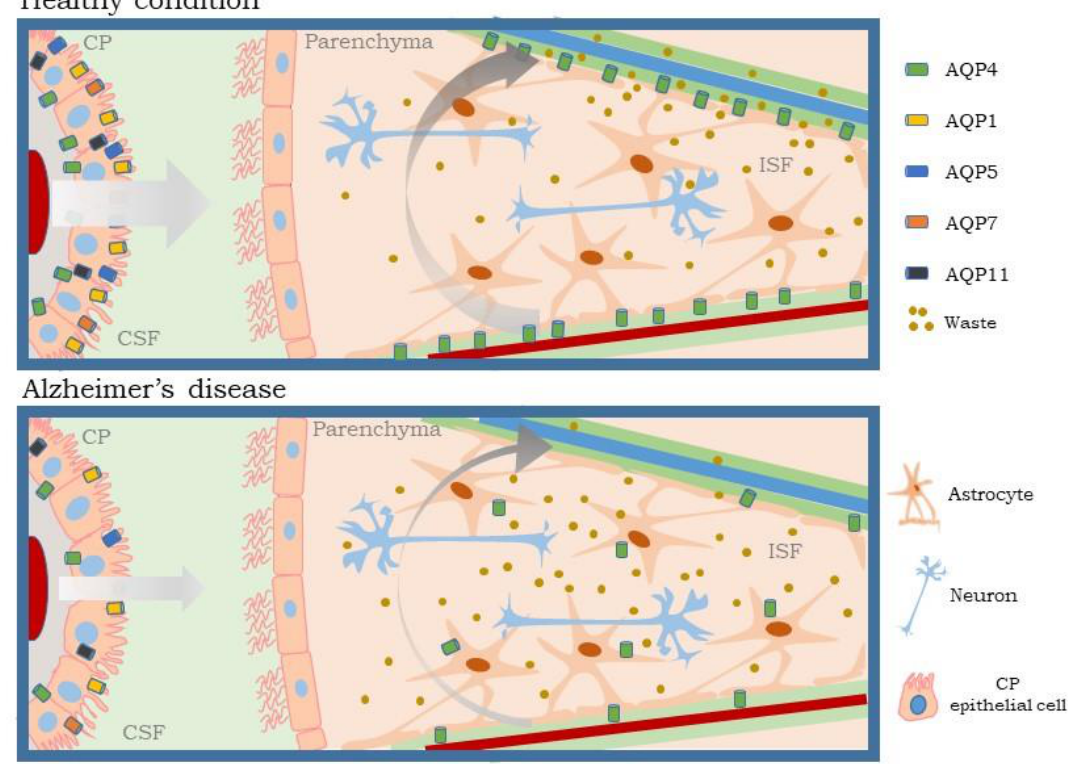
Figure 3. Relationship between choroid plexus and glymphatic system. In healthy conditions ( above ), the choroid plexus forms the BCSFB and produces CSF. CSF flows from the periarterial space to the brain parenchyma via AQP4, located in the end-feet of astrocytes. This movement is favored positive pressure of CSF production from the choroid plexus and the arterial pulse. The CSF/ISF mixture and waste products are cleared by passing into the perivenous space to be taken to the lymphatic tissues. In AD ( below ) the expression of AQPs decreases in choroid plexus epithelial cells causing a reduction in CSF production. The decrease in pressure exerted by the CSF together with the diminution and depolarization of AQP4 in the astrocyte end-feet, reduces the glymphatic function, preventing a correct clearance of the ISF and waste products. AQP: aquaporin;